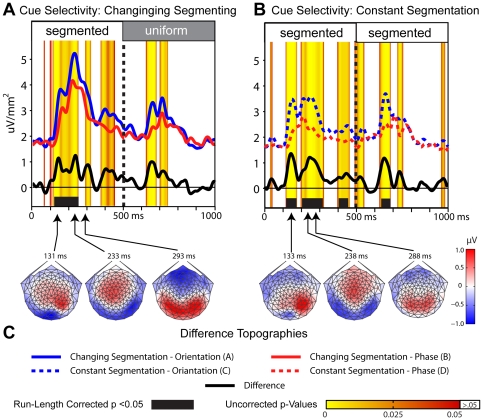
Sensor-space cue selectivity contrasts.Global field power, GFP-differences, and corrected and uncorrected significance levels for differences in the defining texture cue when these cues (A) changed segmentation states, or (B) remained constantly segmented. (C) Shows the topographic distributions of the difference waves at the three peaks in GFP after the texture transient for each of the two cue contrasts.